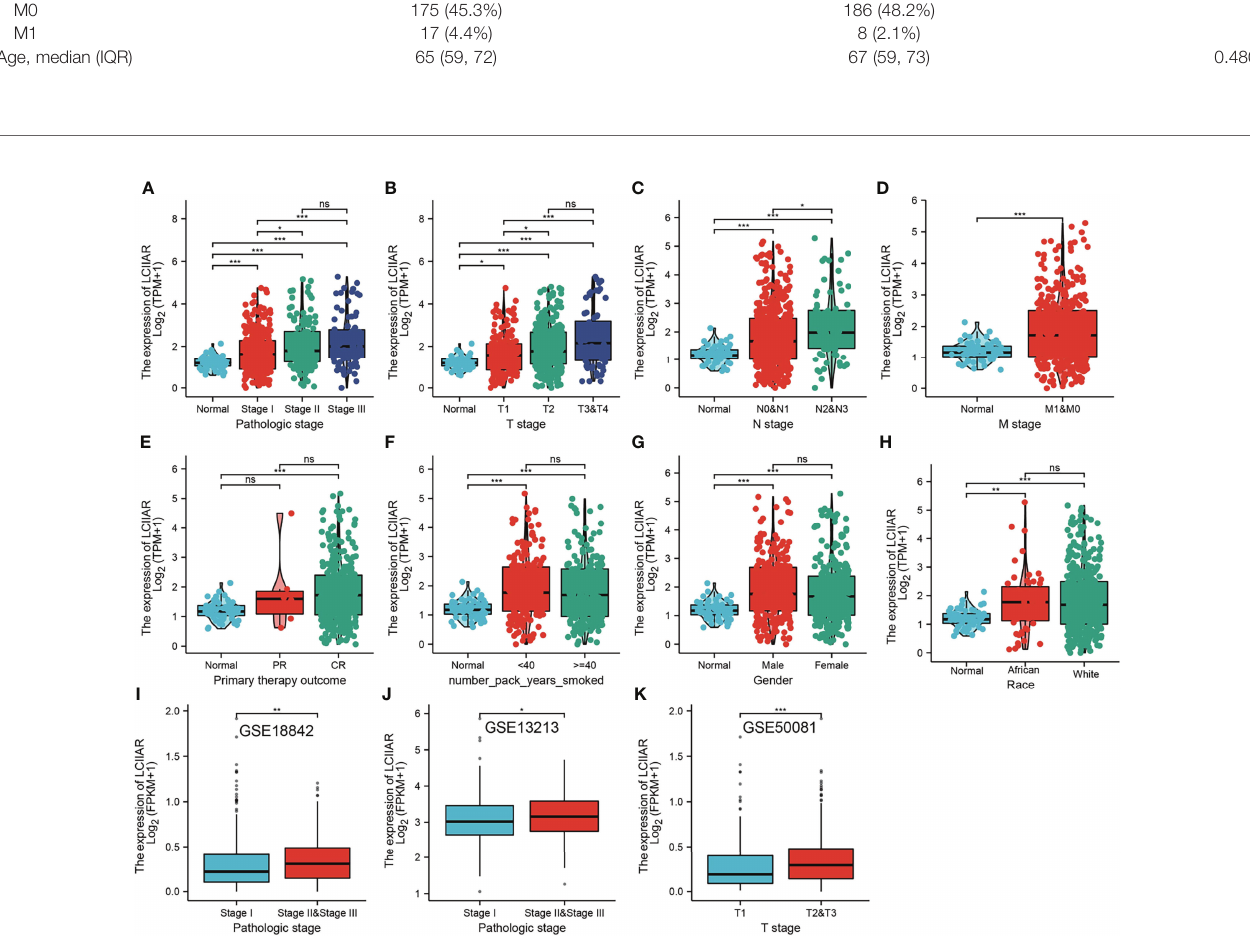
FIGURE 3 | Correlation with LCIIAR expression and clinicopathologic characteristic of LUAD Correlation with LCIIAR expression and clinicopathologic characteristics, including (A) pathological stage, (B – D) TNM stage, (E) primary therapy outcome, (F) smoking, (G) gender and (H) race. (I – K) Correlation with LCIIAR expression and pathological stage, T stage analysis by GEO dataset. NS: p > 0.05, *p < 0.05, **p < 0.01, ***p <